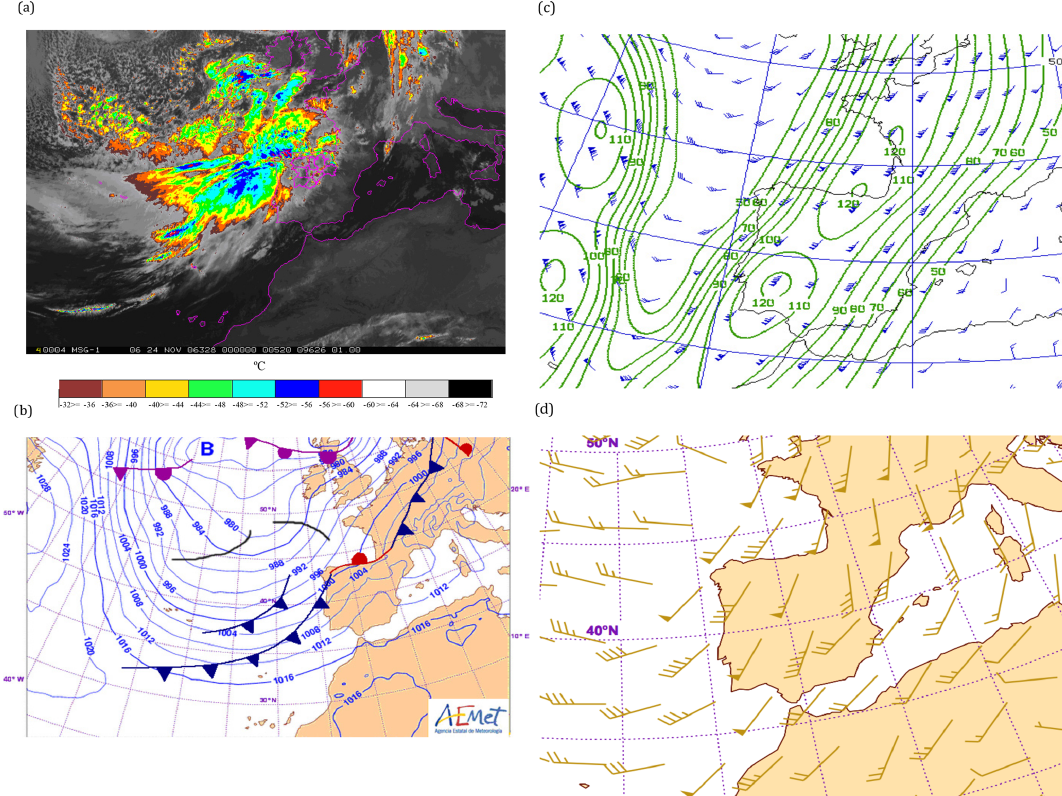
Figure 4. 23–25 November 2006: (a) infrared channel image from MSG on 24 November at 00:00UTC; (b) surface pressure pattern on 24 November at 00:00UTC; (c) 300hPa wind pattern (lines are isotachs, units labelled in knots) on 25 November at 12:00UTC; and (d) 850hPa wind pattern (knots) over the Iberian Peninsula of 25 November at 00:00UTC.